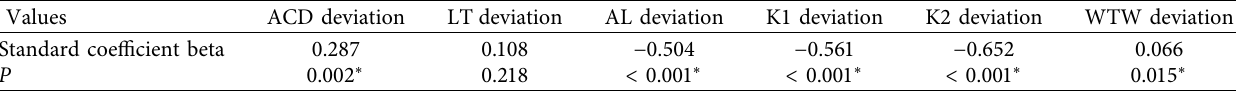
Table 3: Regression analysis of preoperative and postoperative IOL power difference.